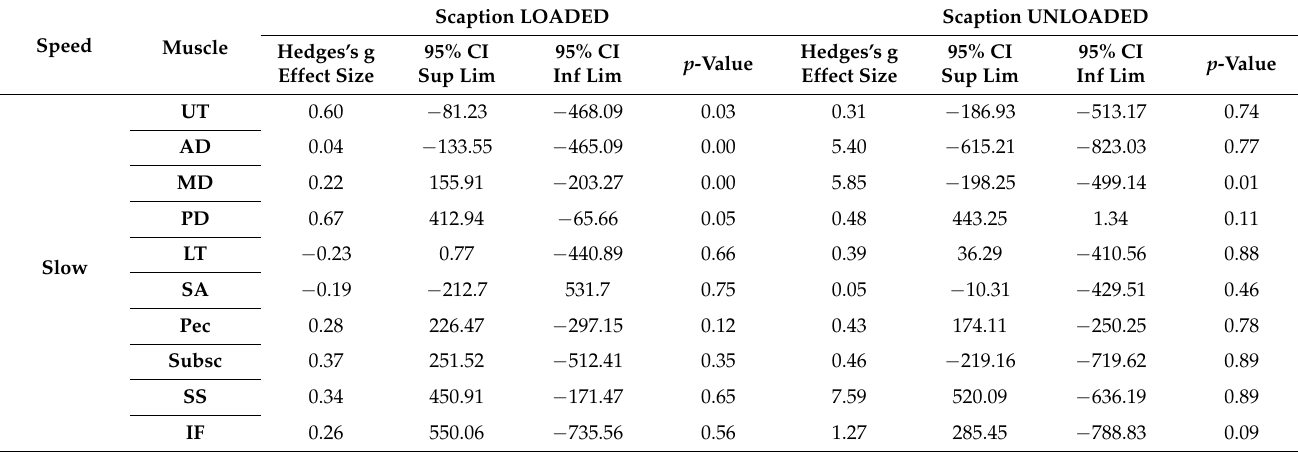
Table 3. Comparative statistics of EMG onset time of activation (ms) during scaption movement prior to and after standardized physiotherapy treatment for SIS movement at slow, medium, and fast speeds; loaded and unloaded